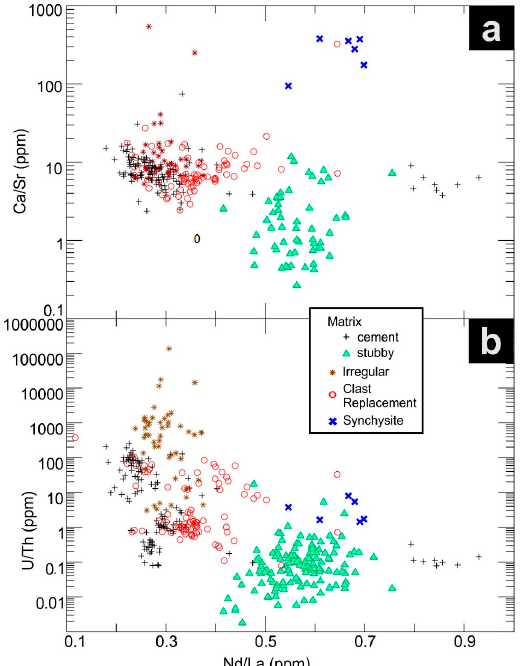
Figure 7. Trace element ratios in bastnäsite and synchysite: ( a ) Ca/Sr vs. Nd/La. Note most stubby matrix bastnäsite is richer in Sr compared to Ca; ( b ) U/Th vs. Nd/La. Note that relative proportions of U to Th separate the textural groupings with the irregular, sulfide-associated group containing more U compared to Th. The stubby matrix group, and to a lesser extent, the clast replacement sub-type, contains more Th than U.